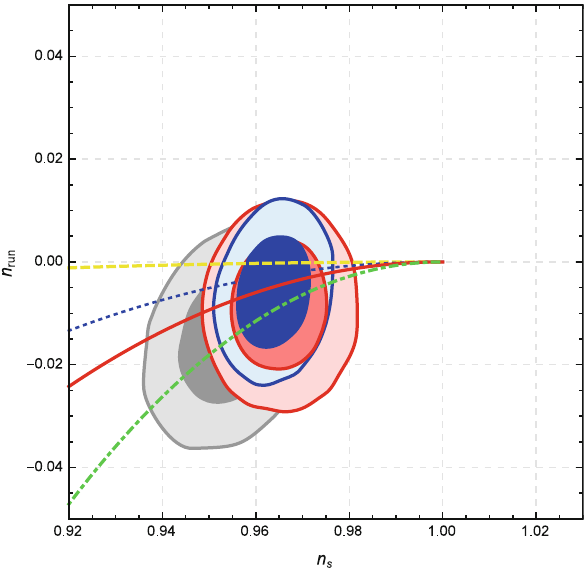
Fig. 3 n s – n run diagram. The area corresponds to Planck data and n s – n run trajectories relate to our model. The dashed yellow , dotted blue , solid red , and dot-dashed green lines correspond to the combinations ( 19 . 6 × 10 − 9 ) , ( 29 . 4 × 10 − 3 ) , ( 39 . 2 × 10 − 20 ) , ( 49 . 3 × 10 − 9